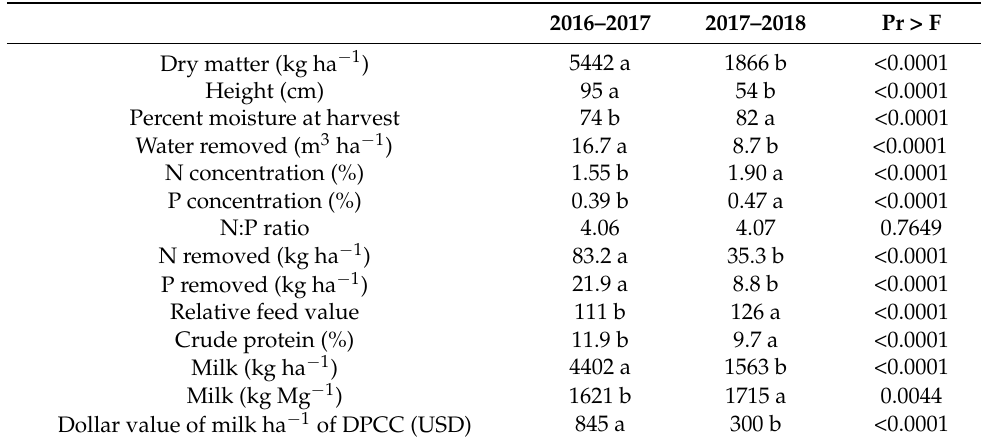
Table 1. Biomass yields, moisture contents, nutrient recoveries, and quality of harvested DPCCs. Means separated by Tukey’s HSD range test. Within the same row, values followed by different letters are statistically